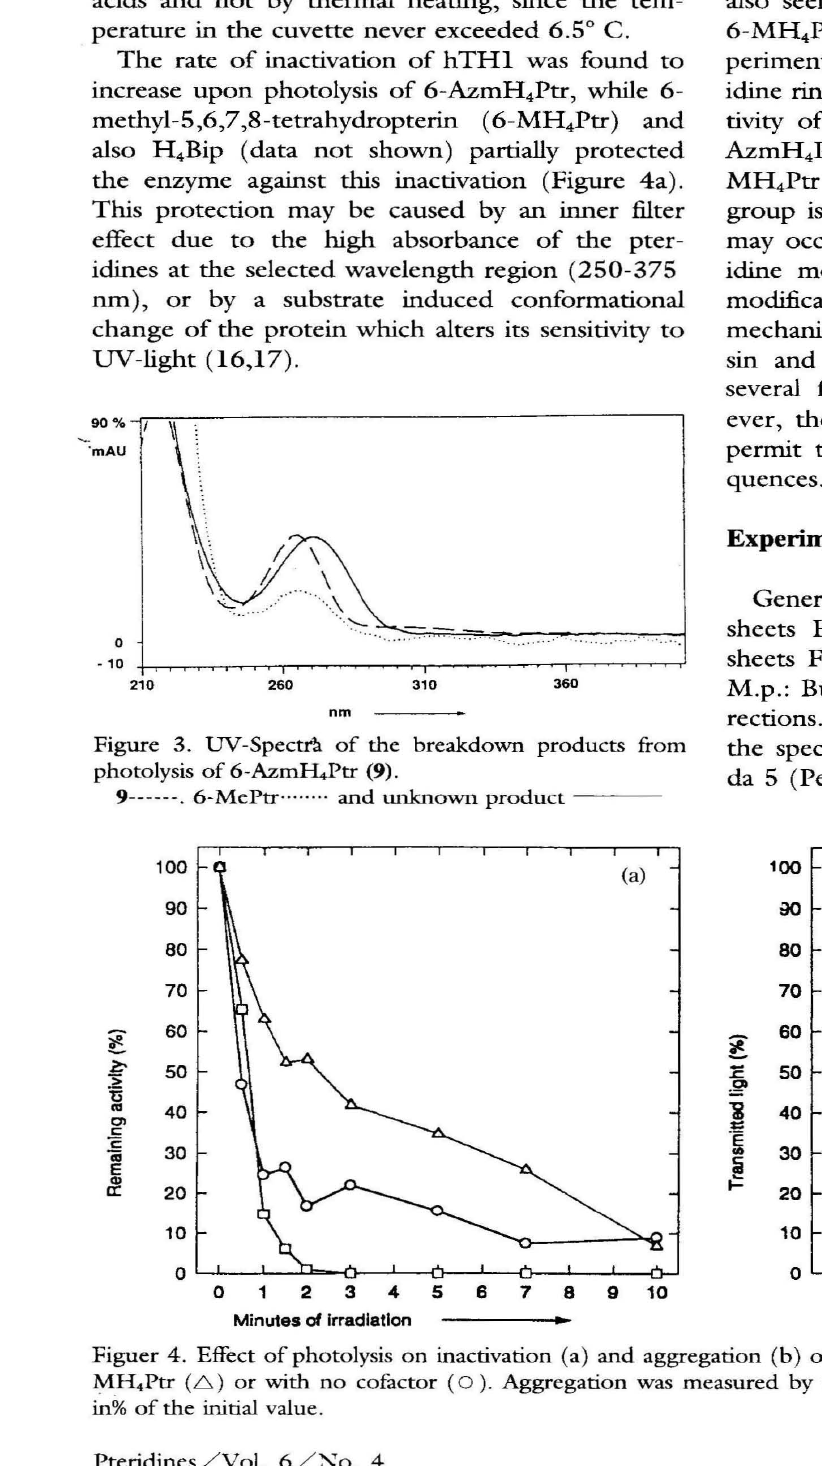
Figuer 4. Effect of photolysis on inactivation (a) and aggregation (b) of hTH1 in the presence of 6-Azm&Ptr (0), 6- MH.Ptr (6 ) or with no cofactor (0 ). Aggregation was measured by the decrease in the amount of transmitted light in% of the initial